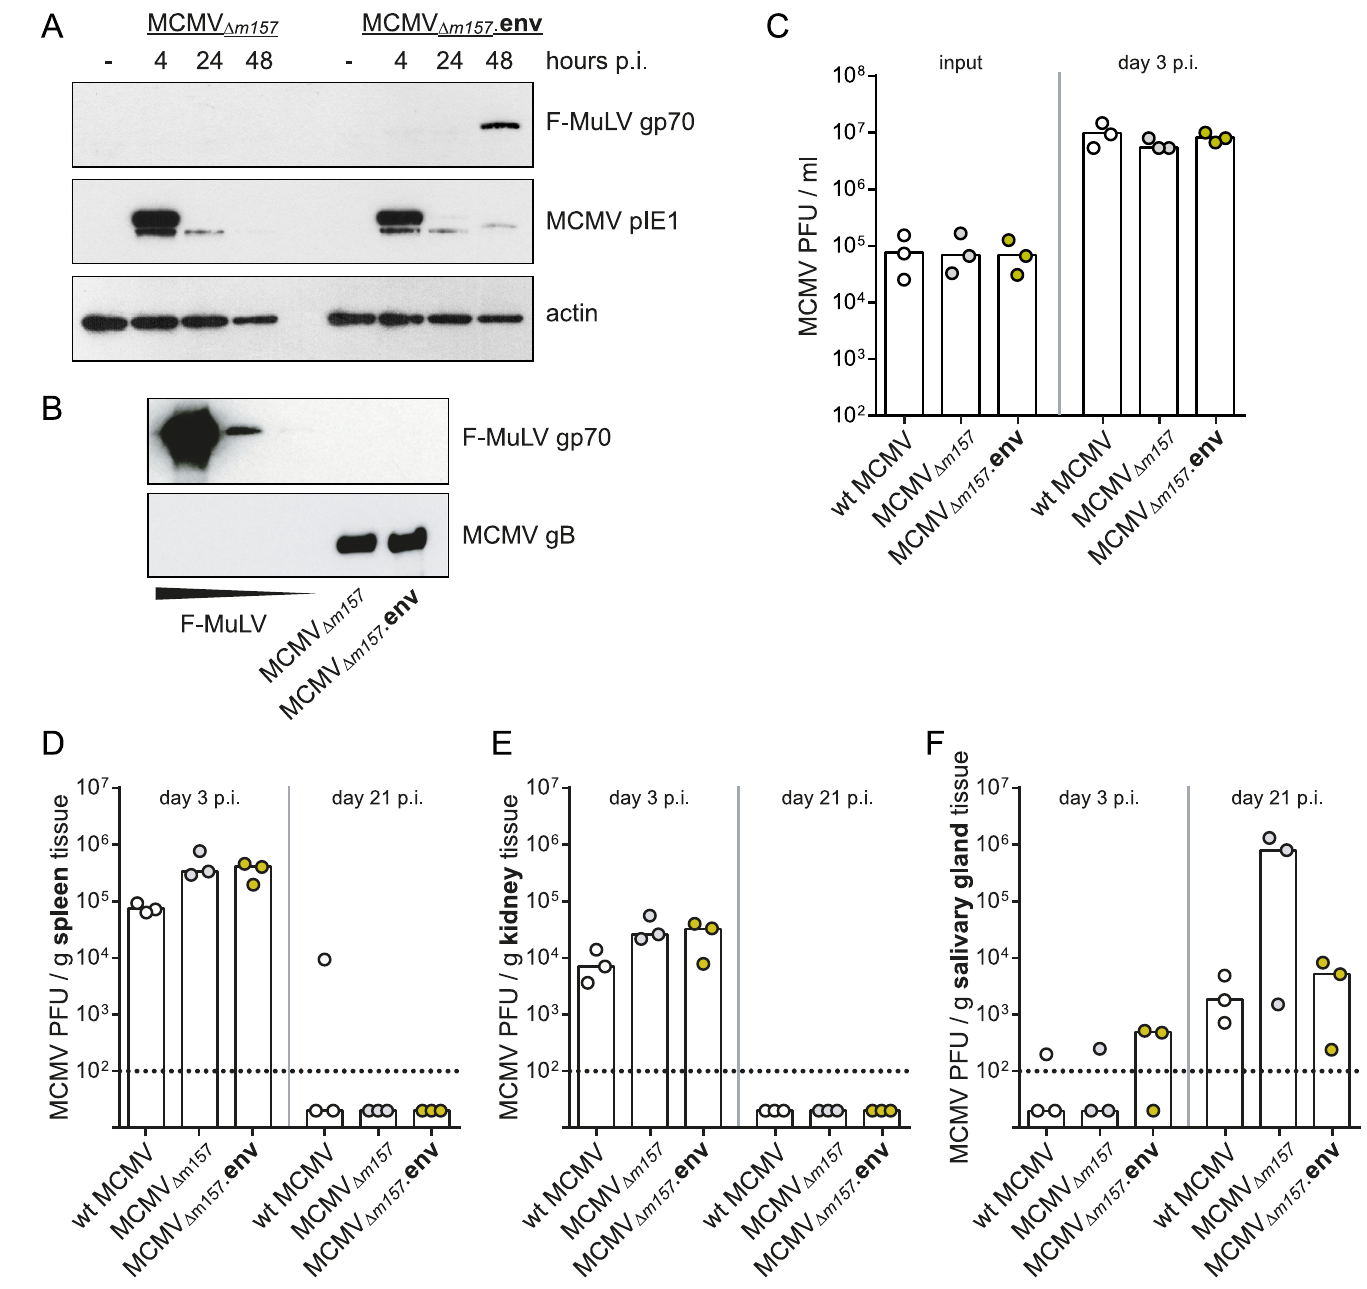
Fig 1. Characterization of MCMV.env. (A) Expression of F-MuLV Env from the MCMV.env vector was verified by immunoblot analysis of lysates of MEF cells infected with the MCMV Δ m157 -based vector MCMV.env or the non-transgene encoding control vector collected 4, 24 or 48 hours after infection. Uninfected MEF cells served as negative control, detection was performed with antibodies directed against the indicated proteins. (B) 2 × 10 5 PFU MCMV.env or MCMV, or different amounts of F-MuLV particles (1 × 10 5 FFU, 5 × 10 3 FFU, or 1 × 10 3 FFU) were subjected to SDS-PAGE and Western Blot. Presence of F-MuLV Env gp70 was probed with gp70-specific polyclonal antibody, detection of MCMV gB served as loading control. (C-F) For characterization of the growth kinetics of the MCMV Δ vector MCMV.env in comparison to non-transgene encoding vector or to wildtype MCMV, in vitro (C) or in vivo (D-F) replication studies were performed. (C) MEF cells were infected with the indicated viruses, and plaque forming units (PFU) of input virus as well as of supernatants collected three days p.i. were analysed. (D-F) CB6F1 mice were infected with 2 × 10 5 PFU of the indicated viruses, and MCMV titers in spleen (D), kidney (E) and salivary gland tissue (F) were analyzed three and 21 days after infection. Data were obtained in one experiment, each dot indicates one infection (C) or one mouse (D-F), bars indicate median values. Data were analysed for statistically significant differences by One Way ANOVA on Ranks with the Dunn’s post test; no significant differences were observed.